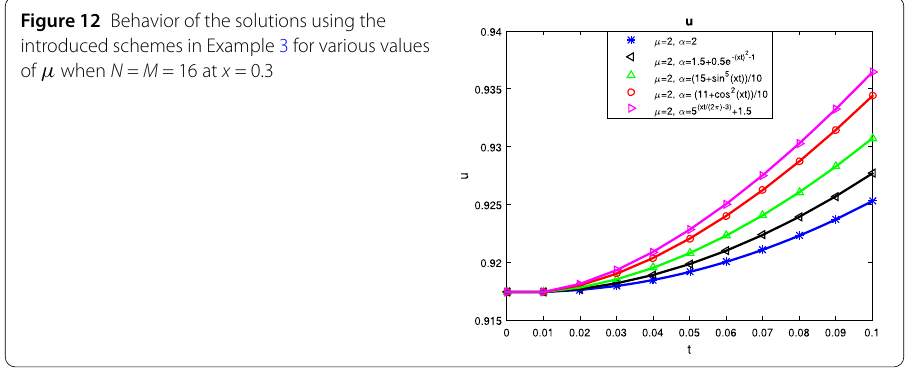
Figure 13 Behavior of the solutions using the introduced schemes in Example 3 for various values of μ when N = M = 16 at x =